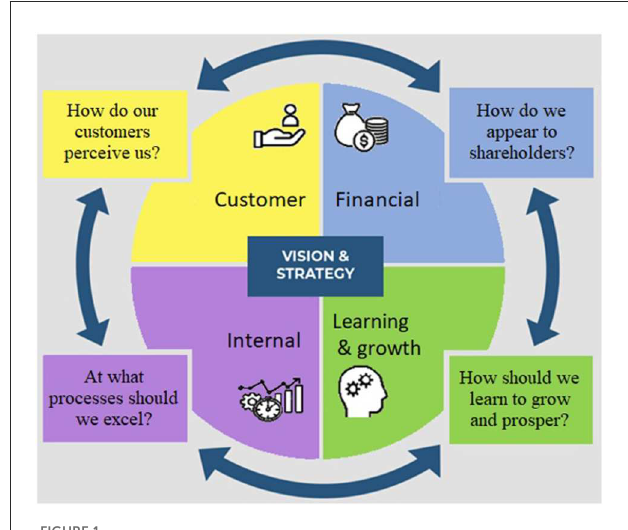
FIGURE1 First generation BSC Perspectives [source: (13) with